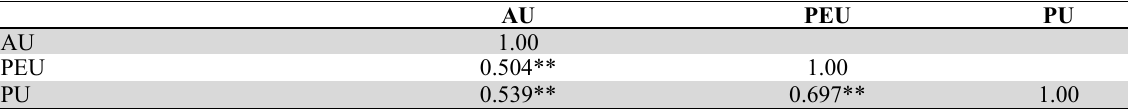
Pearson Correlation Analysis results (n = 189) AU PEU PU